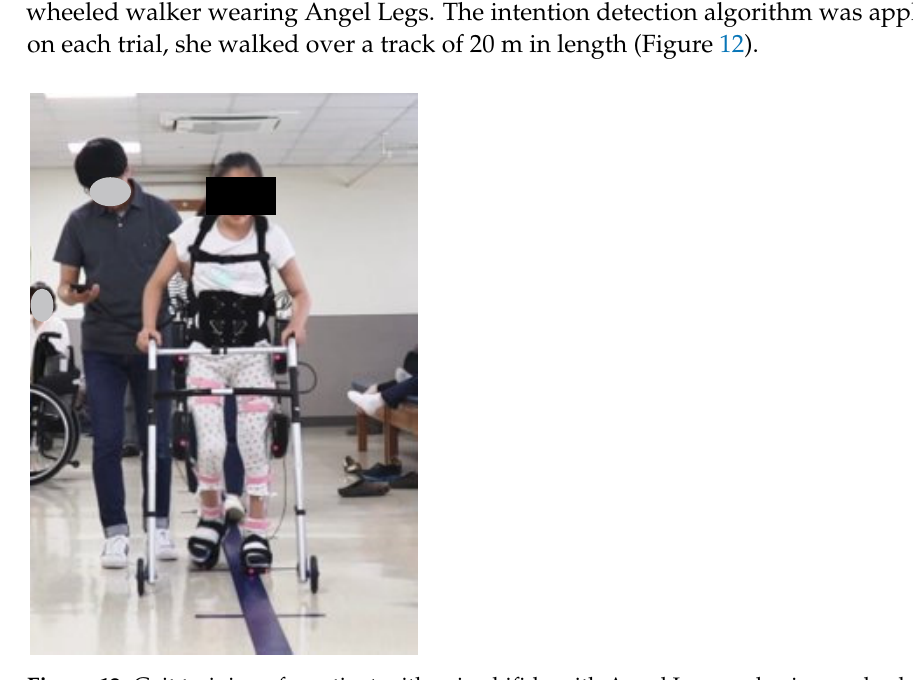
Figure 12. Gait training of a patient with spina bifida with Angel Legs and using a wheeled walker.